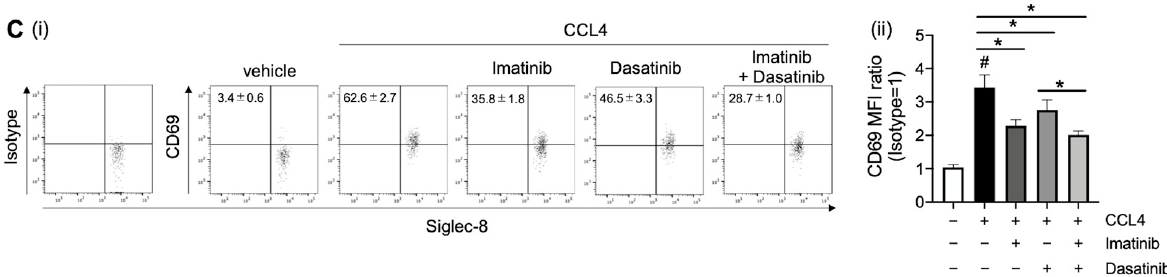
Figure 4. CCL4-mediated eosinophil activation signaling. ( A ) Phosphorylation levels of multiple kinases in eosinophils. Purified peripheral blood eosinophils were treated with CCL4 (10 μ g/mL) for 5 min using a Human Phospho-Kinase Antibody Array Kit (R&D). Phosphorylation levels of platelet-derived growth factor receptor (PDGFR) β , Src kinase family (Lck, Src, and Yes), extracellular signal-regulated kinase (ERK), and control are presented as dots (left panel) or a relative value to vehicle (right panel). ( B ) Colocalization of CCR5, PDGFR β , and Src in eosinophils. CCR5 (red), PDGFR β (green or pink), Src (light blue), and the nucleus (blue) are shown. Images were obtained using an FV3000 confocal microscope (600 × objectives). The scale bars in the bottom-right corner indicate 10 μ m. The results are representative of at least three experiments. ( C ) Purified peripheral blood eosinophils were pretreated with imatinib—a PDGFR β inhibitor (I, 5 μ M) —and/or da- satinib—a Src inhibitor (D, 10 nM) —for 30 min, followed by overnight incubation with CCL4 (10 μ g/mL). CD69 expression in eosinophils was determined [(i) percentage of CD69+ Siglec-8+ double- positive cells and (ii) CD69 median fluorescence intensity (MFI) ratio to isotype control]. The values represent the mean ± SEM of four experiments. # p < 0.05 (vs. nontreatment control); * p < 0.05 (be- tween the two groups).